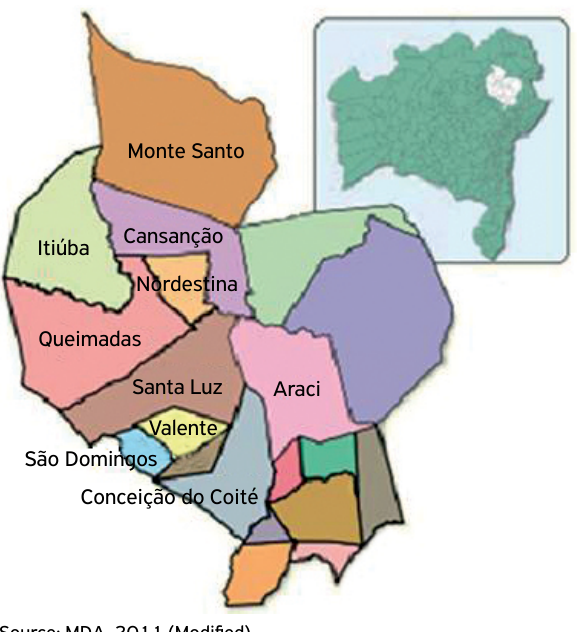
Source: MDA, 2011 Figure 1. Map of the sisal territory of Bahia state, Brazil, highlighting the municipalities selected for the research.